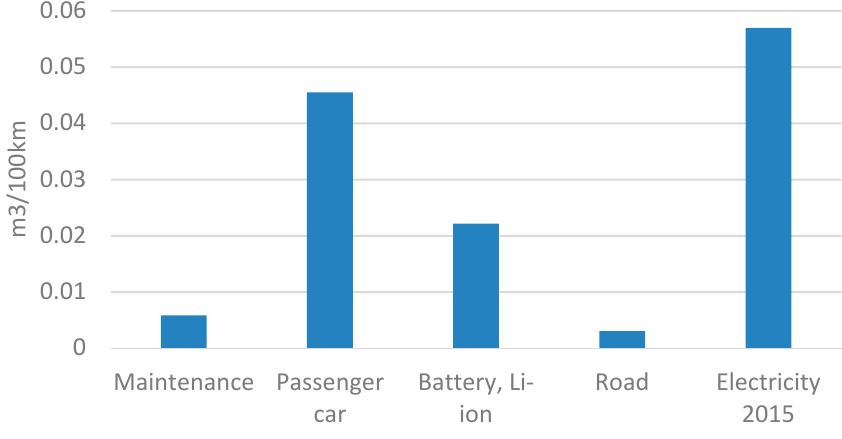
Figure 4. The water footprint of EVs in the CR in 2015.